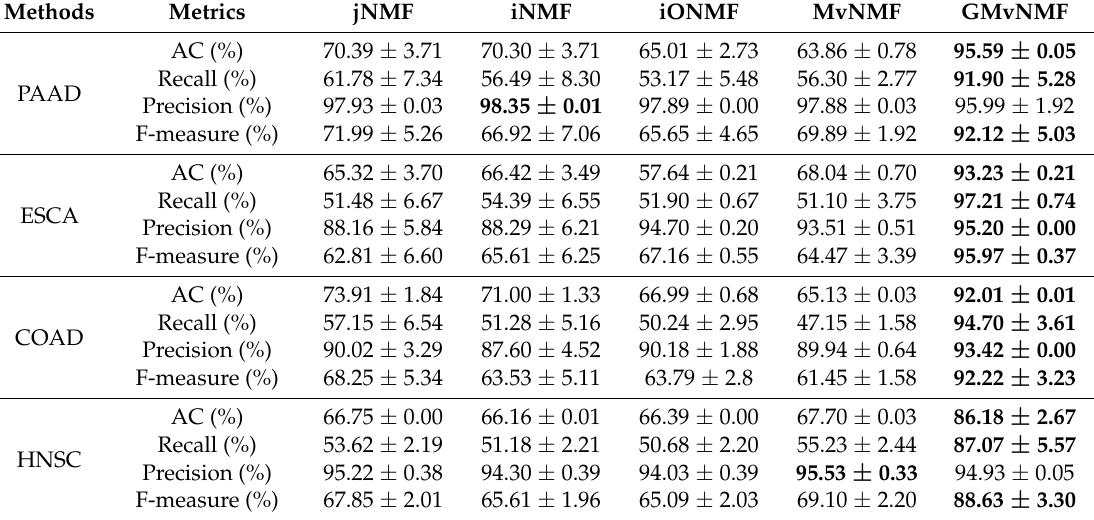
Table 3. The clustering performance on PAAD, ESCA, COAD and